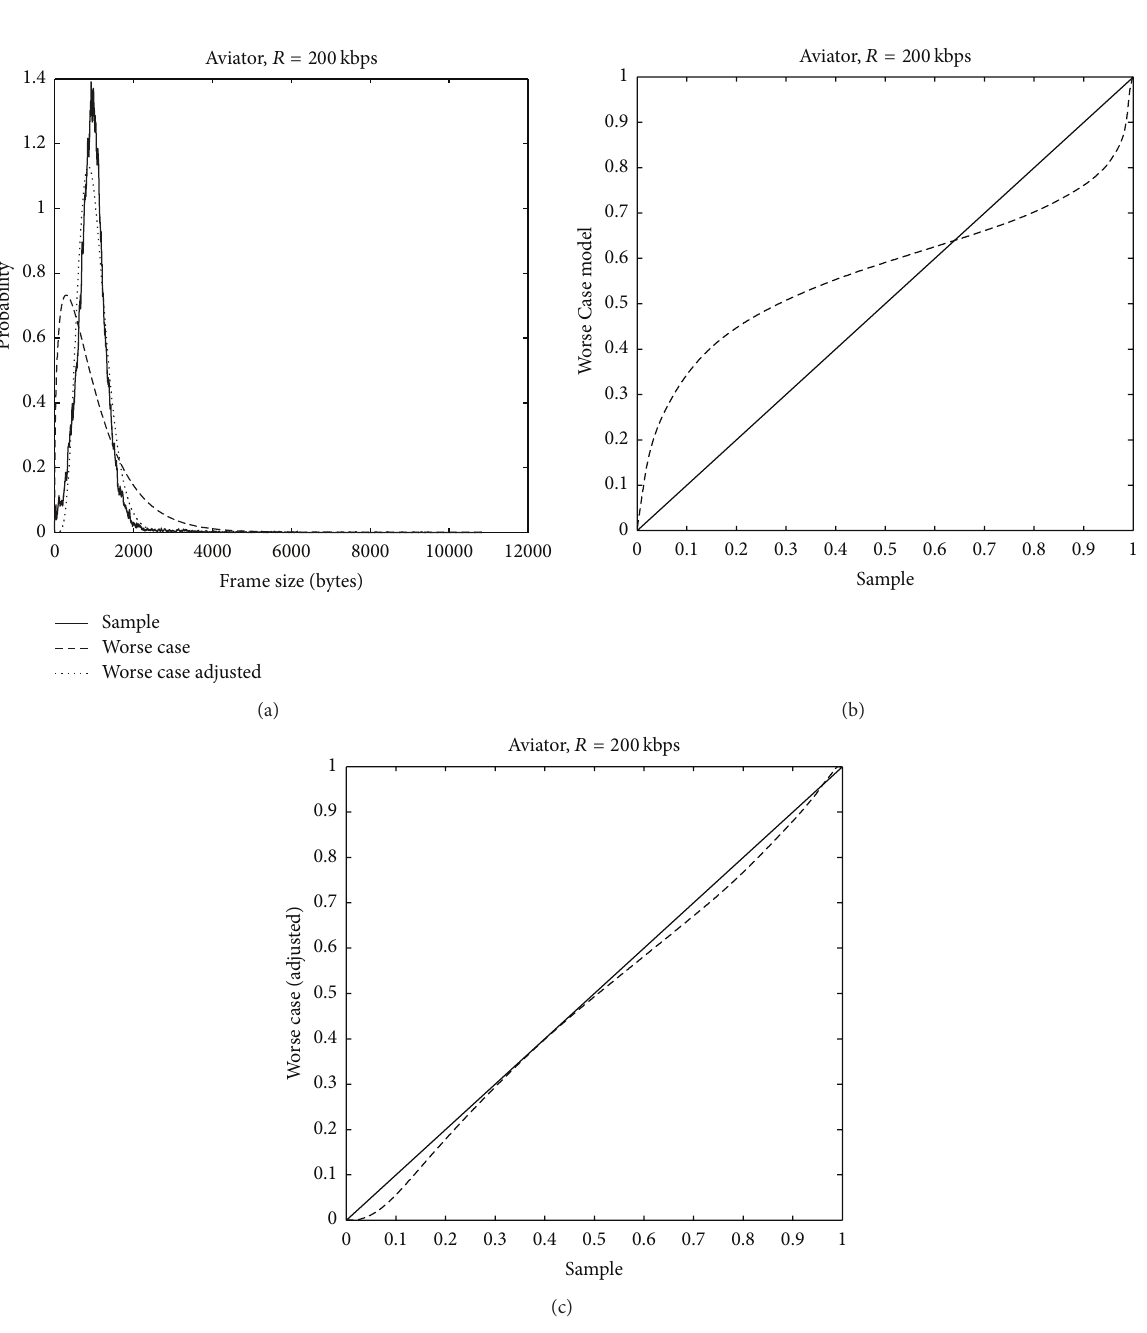
Figure 7: Constrained traffic, Worse Case